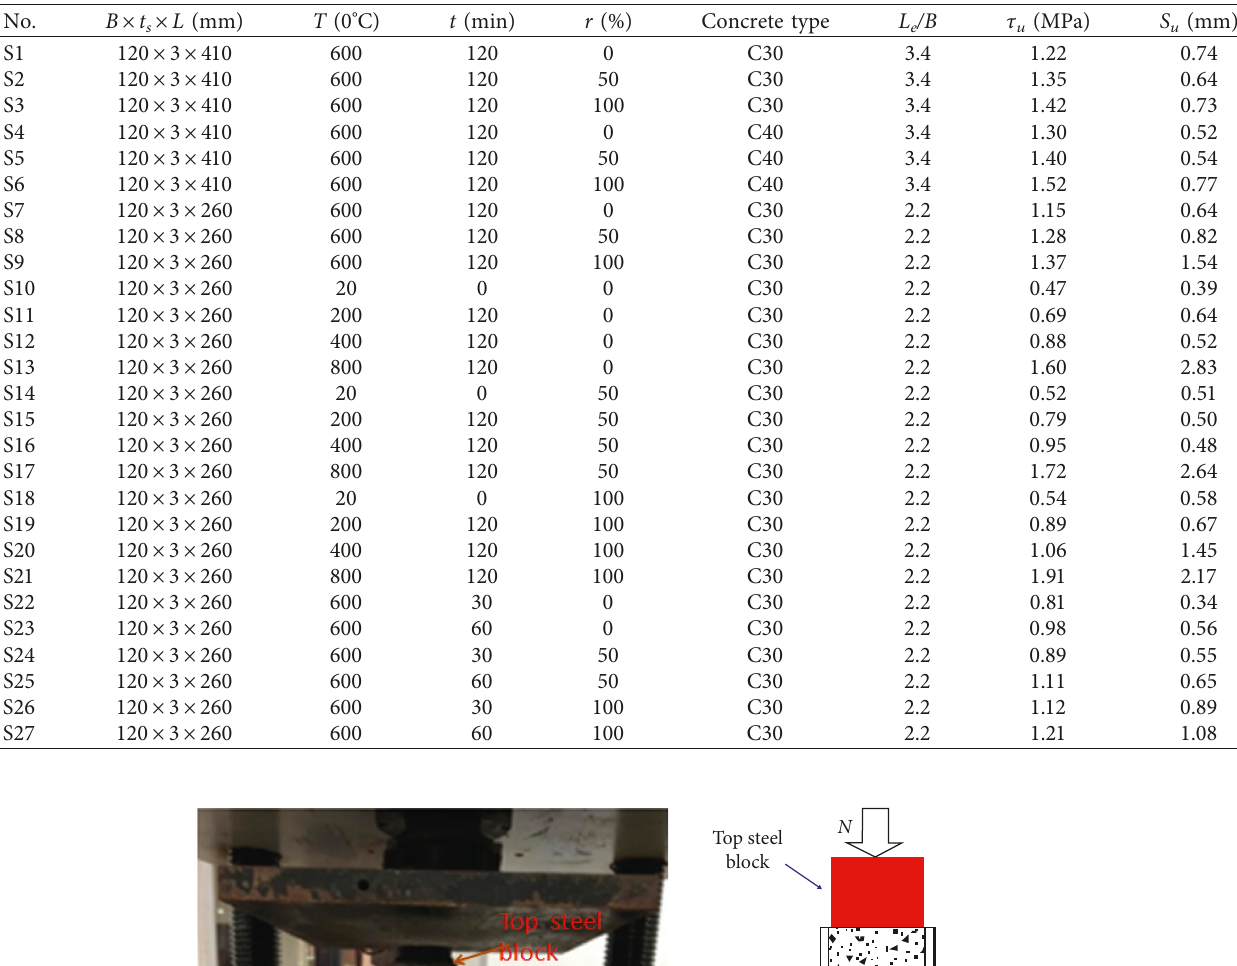
Table 3: Summary of test specimens and